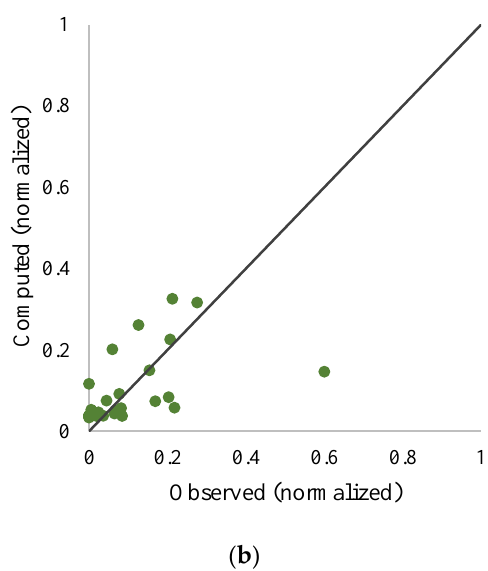
Figure 12. ( a ) Results of precipitation prediction using simple, weighted and neural averaging methods and observed precipitation; ( b ) Scatter plots for verification step using neural ensemble method based on scenario 2 for Girne station.